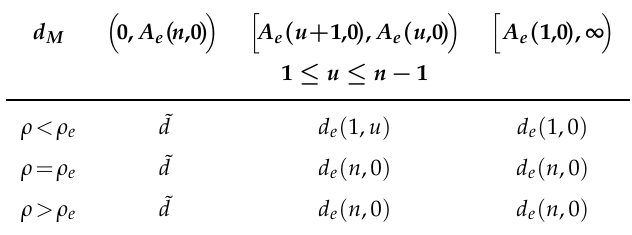
Table 9. Optimal solutions d (cid:63) n with respect to ρ and d M for v = 1. The vectors for ρ = ρ e are representative optimal